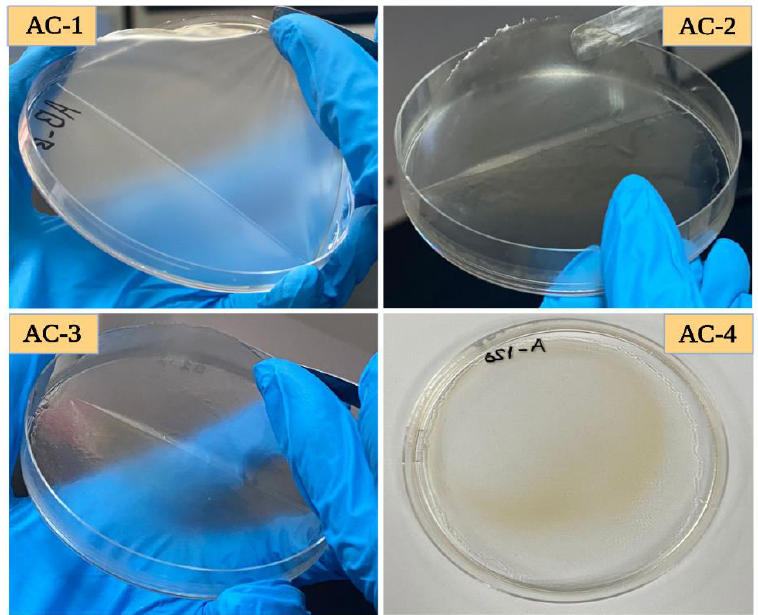
Figure 1. Visual assessment of SA–AG-based composite edible films; AC-1/Control, AC-2 contains 15 μL of CEO, AC-3 contains 20 μL of CEO, and AC-4 contains 30 μL of CEO.